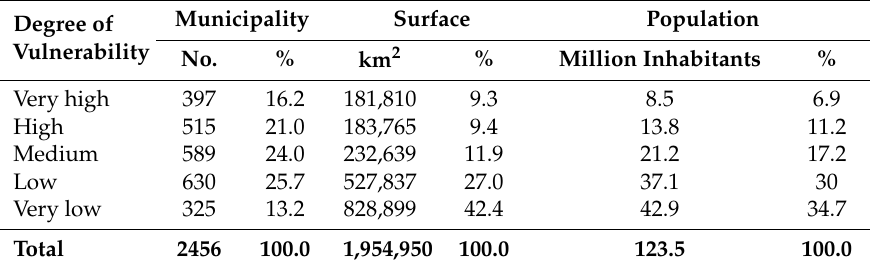
Table 9. Distribution of number of municipalities, surface area, and population by degree of social vulnerability to